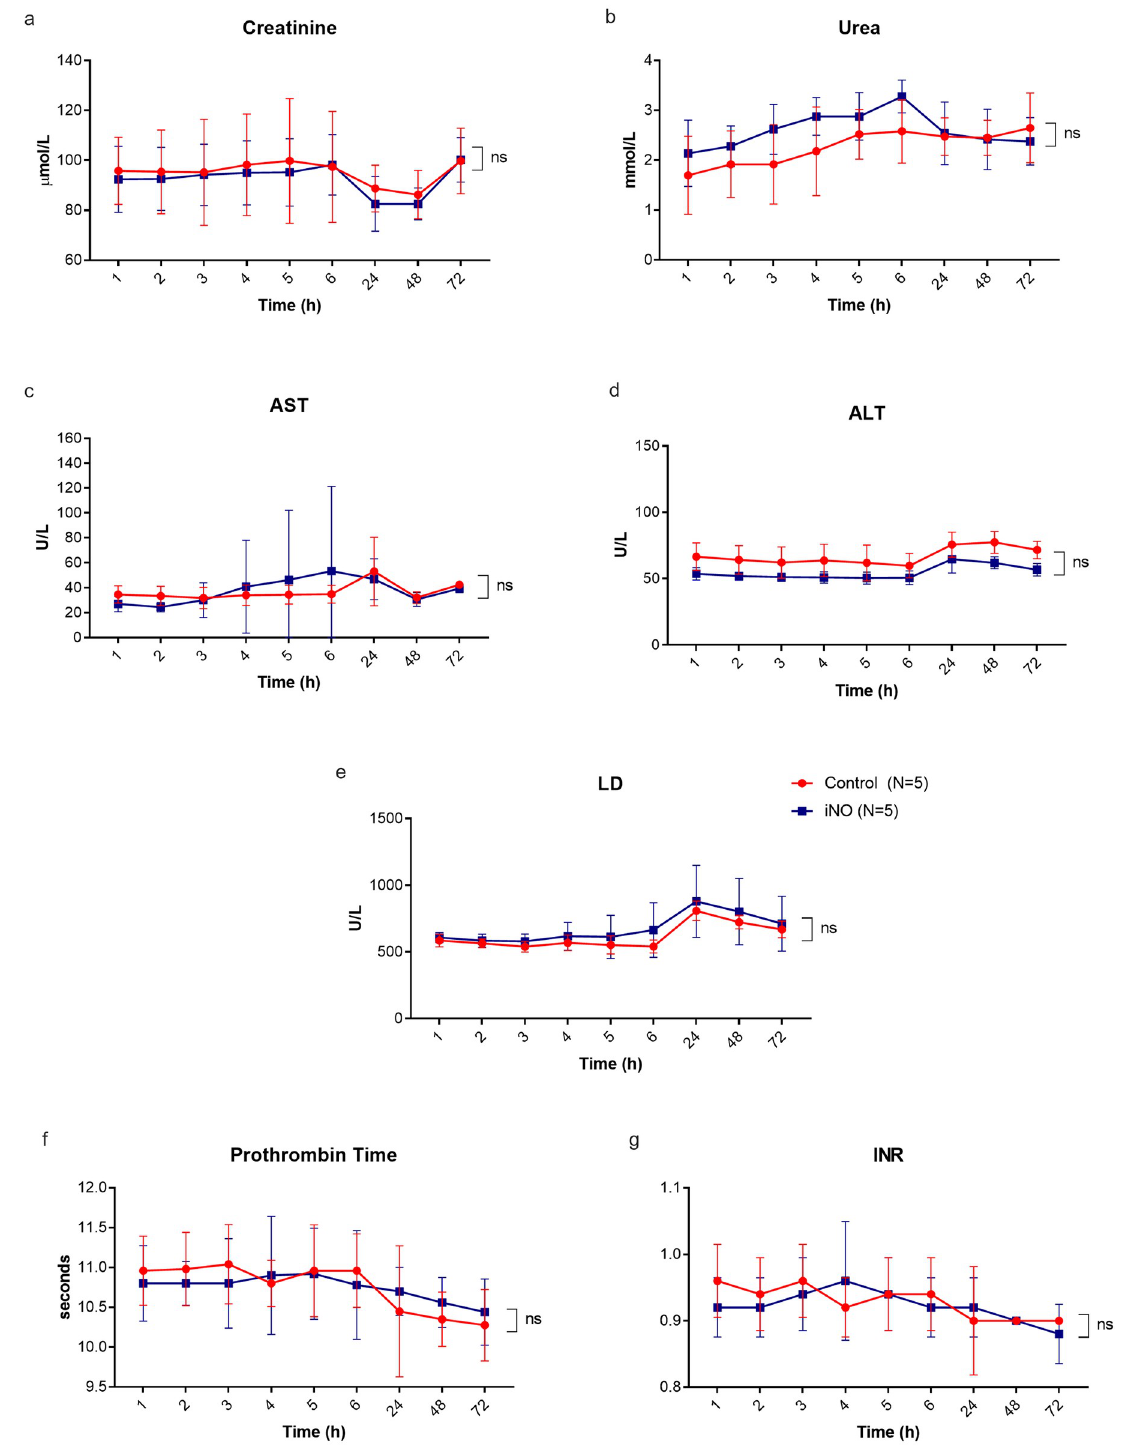
Fig 7. Biochemical analyses of control (red line, n = 5) versus iNO treated animals (blue line, n = 5). Venous blood samples were collected hourly during the intervention phase and daily during the follow-up period in animals of both groups. Kidney function markers, liver enzymes, and coagulation parameters were stable and similar in both groups. Data are displayed as mean ± SD for each time-point. Definition of abbreviation: AST = aspartate aminotransferase, ALT = alanine aminotransferase, LD = lactate dehydrogenase, PT = prothrombin time, INR = international normalized ratio, and ns = non-significant.